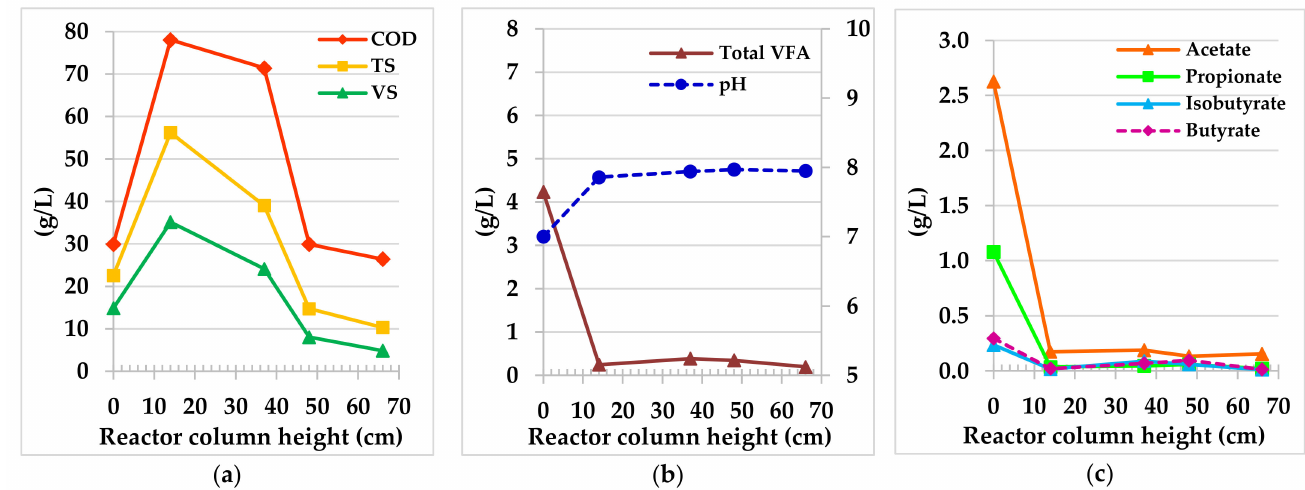
Figure 3. Hybrid anaerobic reactor profile: ( a ) COD, TS, and VS; ( b ) total VFA and pH; ( c ) VFA composition. Sampling ports: P3 (14 cm), P2 (37 cm), P1 (48 cm). COD—Chemical oxygen demand; TS—total solids; VS—volatile solids; VFA—volatile fatty acids.